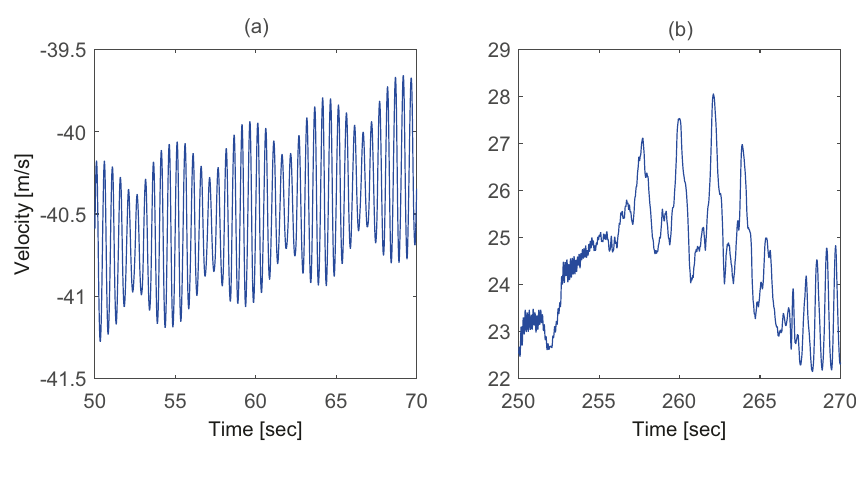
Figure 8: East/west velocity of FFU C